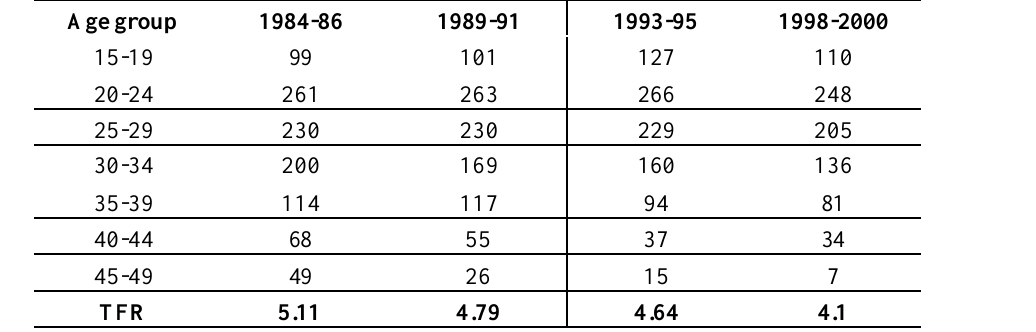
Source: Nepal Demographic and Health Survey 2001 table 4.3 Table III : Among all women who have given birth, percentage who had their first birth by specific ages, and median age at first birth, by current age, Nepal 2001